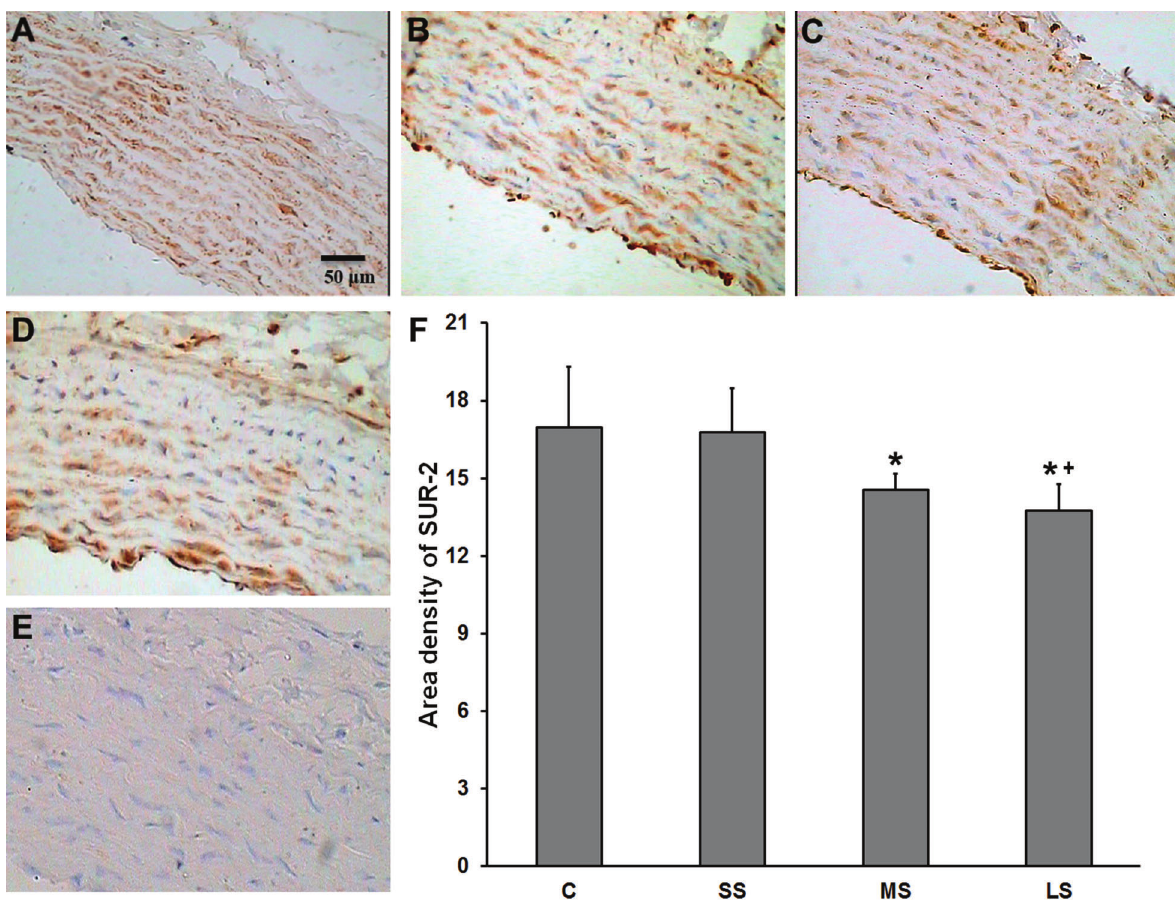
Figure 3. Immunohistochemical staining of sulfonylurea receptor-2 (SUR-2). A , Control (C); B, short-term smoking (SS) group; C , middle-term smoking (MS); D , long-term smoking (LS) groups; E , negative control ( (cid:1) 400); F , quanti fi cation of the staining. Data are reported as means ± SD. *P o 0.05 compared with C group; + P o 0.05 compared with SS group